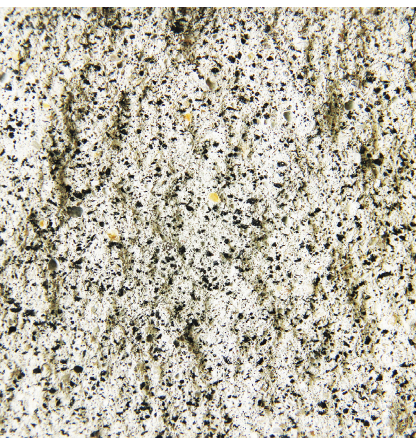
Figure 16: Profile map of K1 group with a uniformity of 1.16. The mixing amount of cellulose ether is 4.6351kg and the substitution rate of rubber is 0.4268.